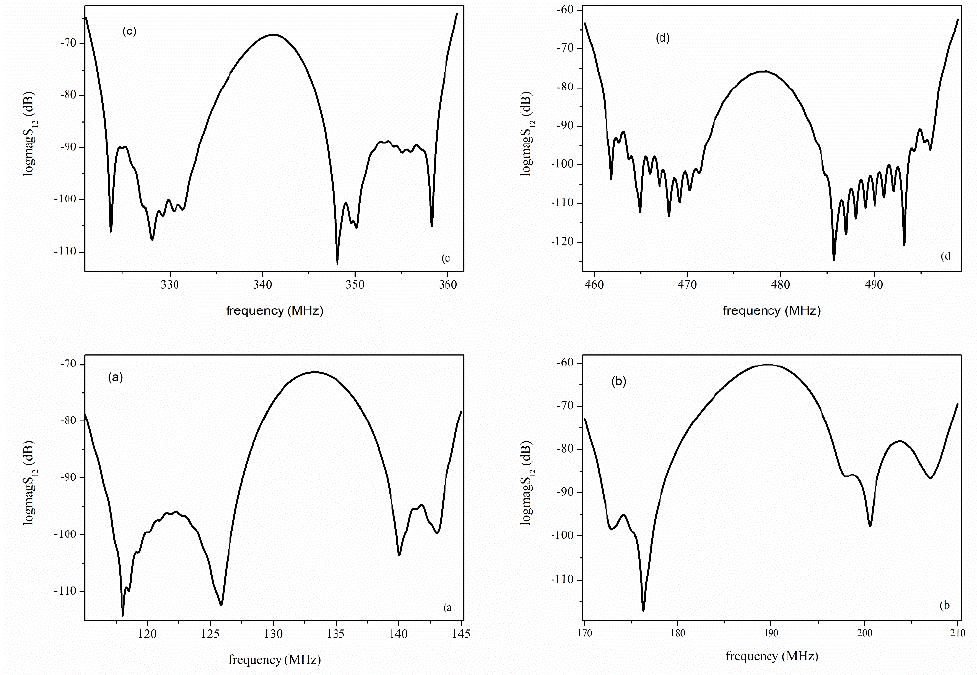
Figure 1. The scattering parameter S 21 vs. frequency curves of ( a ) R m , ( b ) S m , ( c ) the R m third harmonic, ( d ) the S m third harmonic.